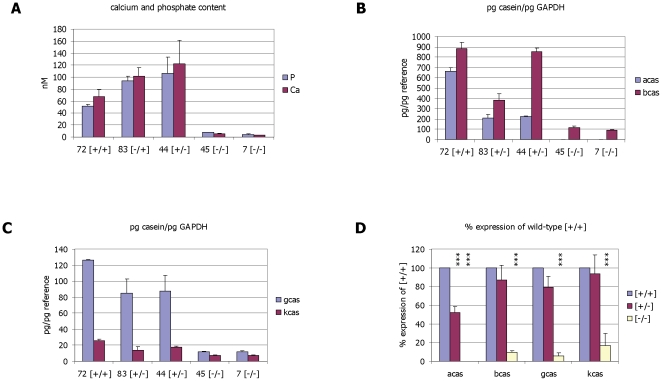
Analysis of milk calcium and phosphate levels and milk protein gene expression.
Panel A: Calcium and phosphate content of mouse milk was determined as indicated in the methods section. Concentrations are given in nM. Panel B: Quantitative PCR analysis of α-casein and β-casein gene expression. cDNA derived from representative wild-type, heterozygous [+/−] and homozygous [−/−] α-casein deficient mice was analysed using primer pairs specific for α-casein, β-casein and the reference gene GAPDH. Expression of the casein genes was correlated with the reference gene and is expressed as pg casein/pg GAPDH. Panel C: Quantitative PCR analysis of γ-casein and κ-casein gene expression. Expression of the γ and κ-casein genes was correlated with the reference gene and is expressed as pg casein/pg GAPDH. Panel D: Correlation of casein gene expression in wild type [+/+], heterozygous [+/−] and α-casein deficient mice [−/−] using quantitative PCR. Casein gene expression was correlated with the expression of the reference gene β-actin. Quantification of α-casein was done in 3 [+/+], 7 [+/−] and 5 [−/−] mice. Quantification of β-casein was done in 3 [+/+], 8 [+/−] and 4 [−/−] mice. Quantification of γ- and k-casein was done in 3 [+/+], 3 [+/−] and 3 [−/−] mice. Expression in heterozygous and α-casein deficient mice is presented as percentage of median casein gene expression in wild-type control mice [+/+] (set to 100%). Error bars represent standard deviations. For comparisons against wild-type mice in a one-way ANOVA p<0.05 is indicated by *, p<0.01 by **, and p<0.001 by ***. Exact p values are presented in table 6.